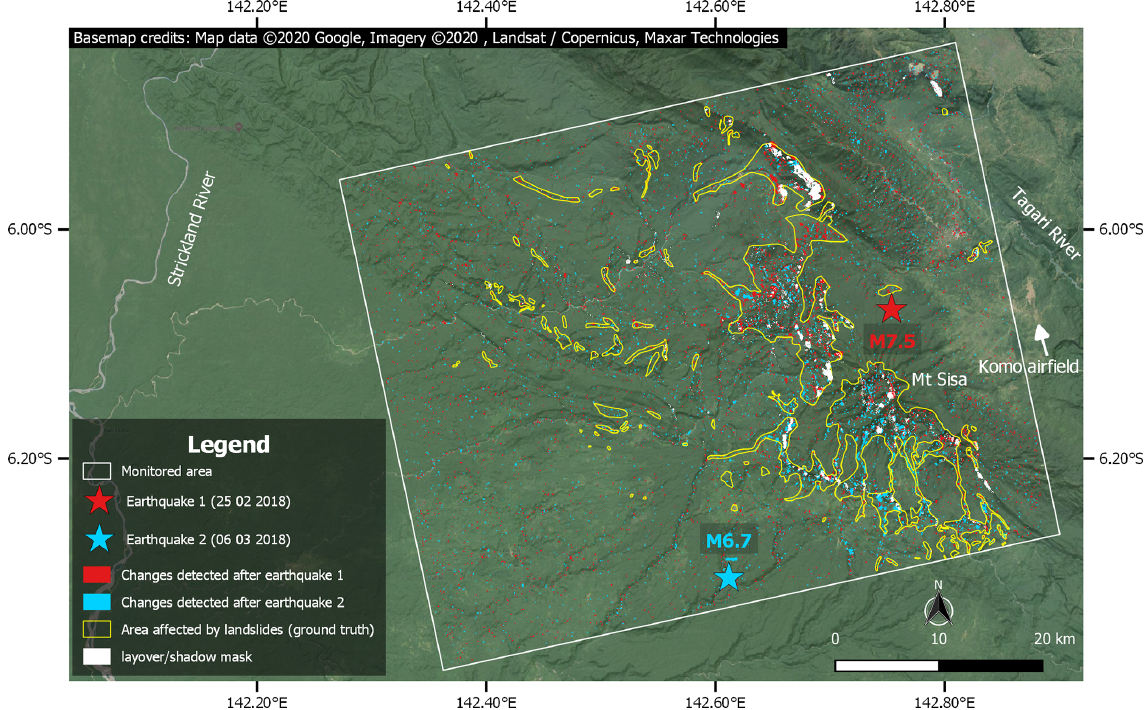
Figure 6. The location of the epicenters of the two main earthquakes and the distribution of segments representing SAR amplitude changes for the change detections 9 (red) and 10 (blue). Yellow polygons are areas affected by clusters of landslides, as interpreted from optical data. The white rectangle identifies the AoI (see Fig.